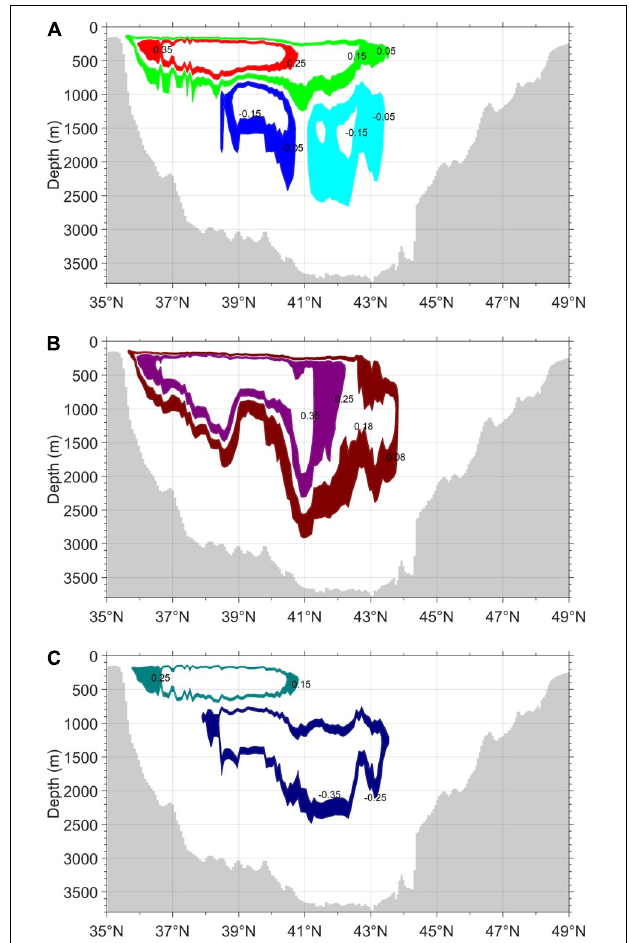
FIGURE 9 | Turnover time ( tot v ) in the (A) mean convection, (B) deep convection, and (C) shallow convection cases in the meridional overturning stream functions. The turnover times are 20.6 years (0.25–0.35 Sv streamlines, red), 34.5 years (0.05–0.15 Sv streamlines, green), 31.9 years ( − 0.15 to − 0.05 Sv streamlines, blue), and 49.2 years ( − 0.15 to − 0.05 Sv streamlines, cyan) years in the panel (A) mean convection case; 63.7 years (0.25–0.35 Sv streamlines, purple) and 79.8 years (0.08 ∼ 0.18 Sv streamlines, maroon) in the panel (B) deep convection case; and 13.3 years (0.15–0.25